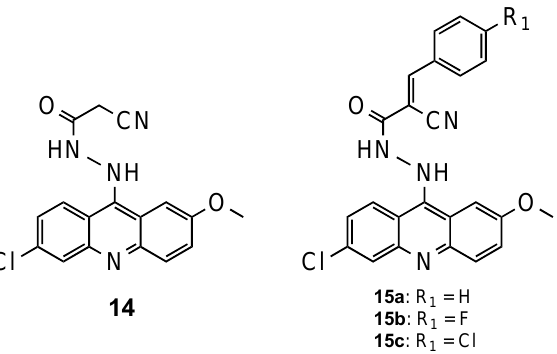
Figure 9. Compounds 14 and 15 developed by Silva and co-workers [19].